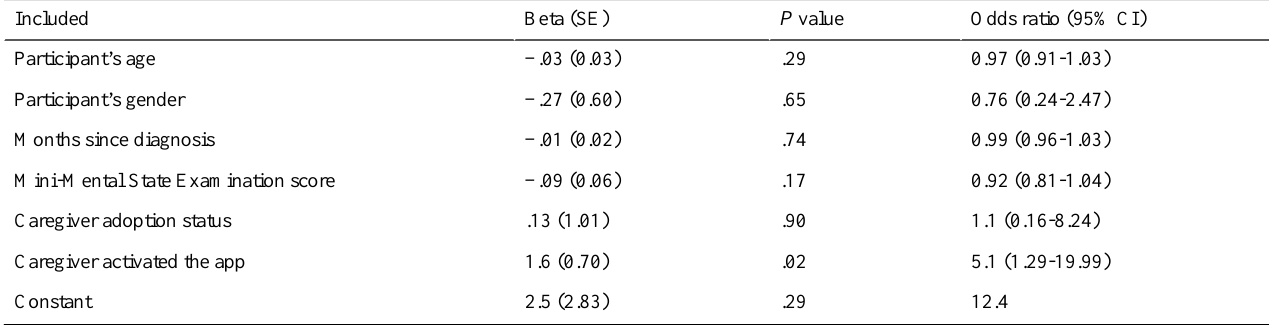
Table 3. Logistic regression: Impact of baseline characteristics and caregiver’s app activities on participant adoption